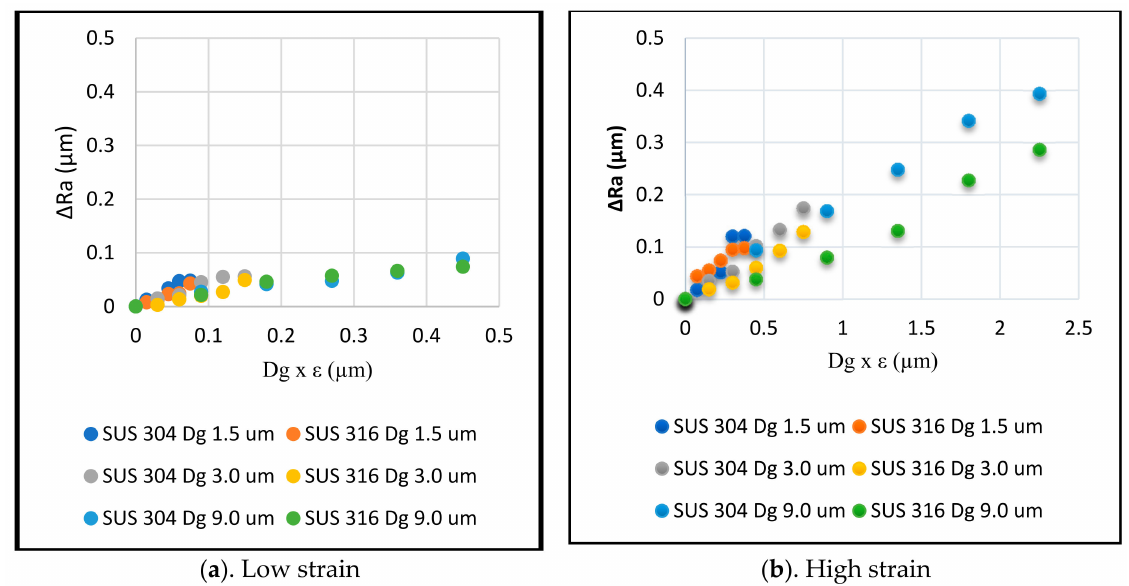
Figure 7. The increase in surface roughening due to grain size and true strain of SUS 304 and SUS 316, low strain ( a ) and high strain ( b